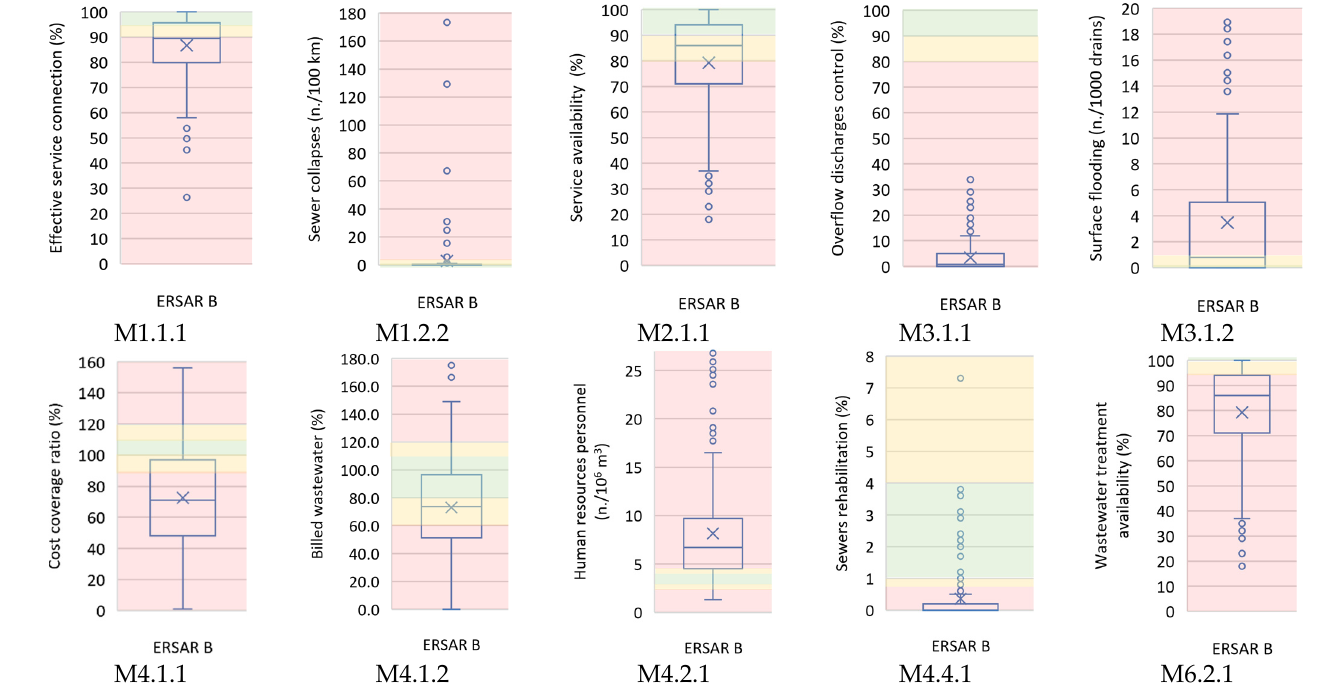
Figure 4. Results of testing applied to data available from ERSAR report for 2018 (257 type B utilities).